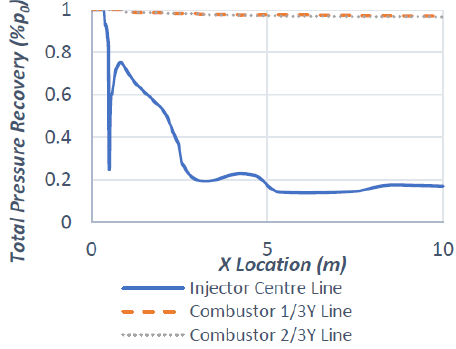
Figure 22. Flame structure of a single strut combustor in terms of static temperature (K).